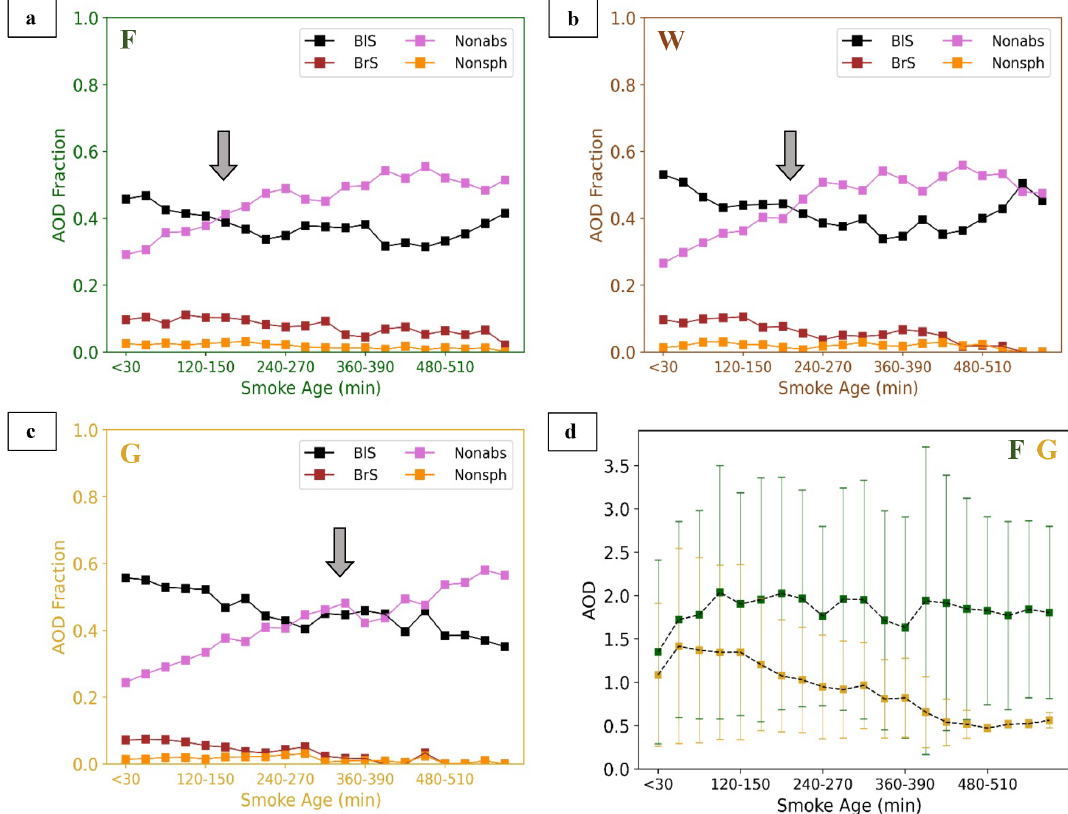
Figure 6. MISR particle-type component AOD fractions (in terms of the contribution to the total AOD, from 0 to 1) by smoke age for (a) Forest plumes, (b) Woody plumes, and (c) Grassy plumes. In panel (d) , the MISR mid-visible AOD is plotted by age for forest and grassy plumes, for reference. The points represent the mean values, and the whiskers are standard deviations. Arrows help highlight the points of important particle-size